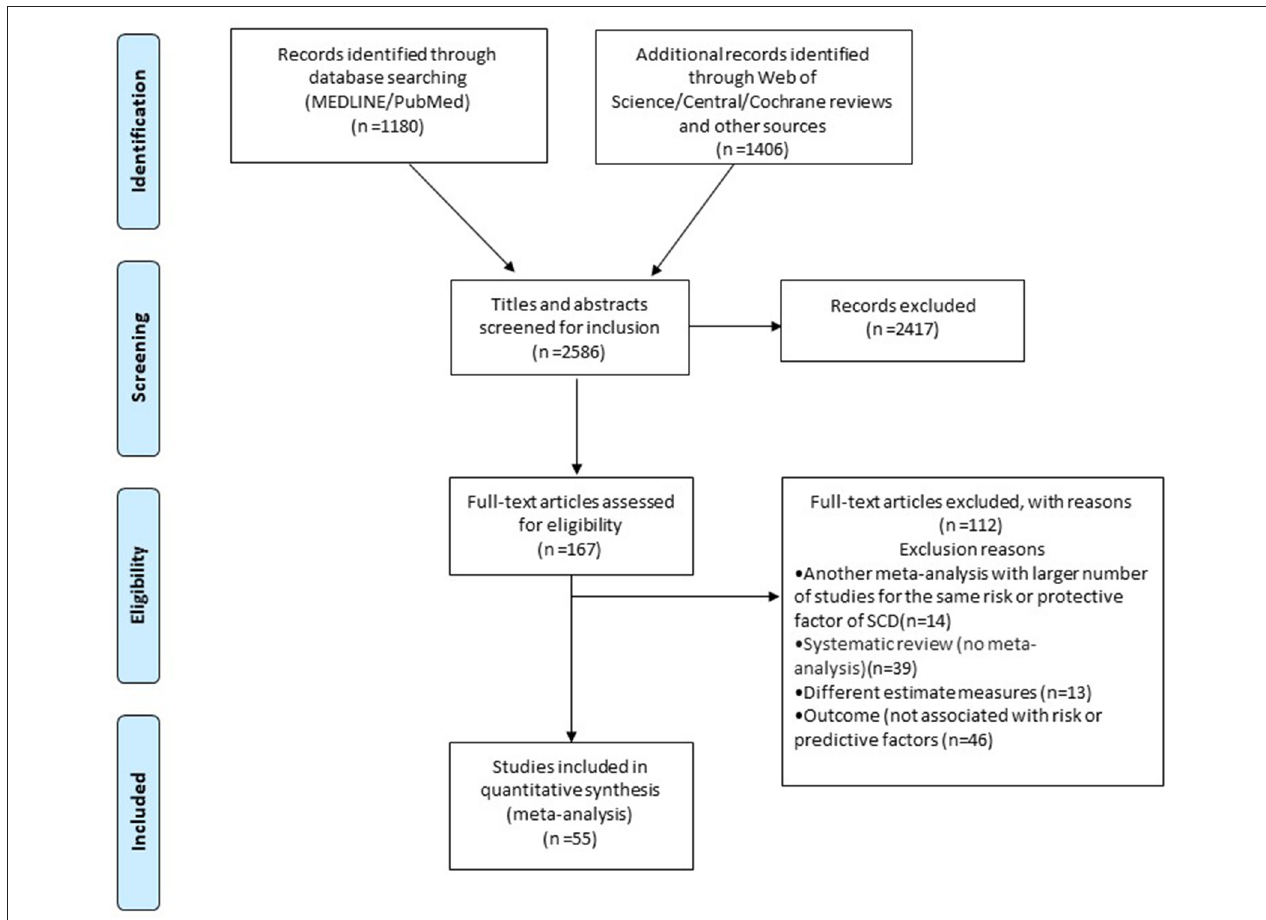
FIGURE 1 | Flowchart of the study selection process (SCD, sudden cardiac